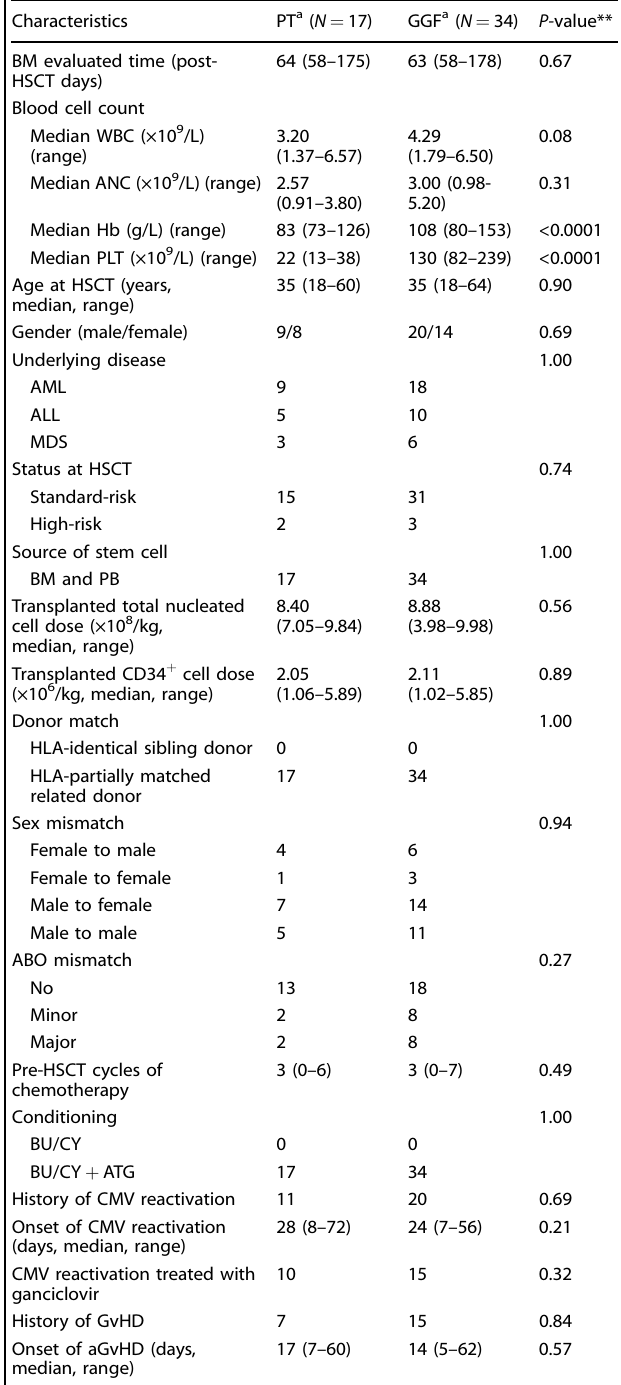
Table 1. Characteristics of allo-HSCT patients with PT and